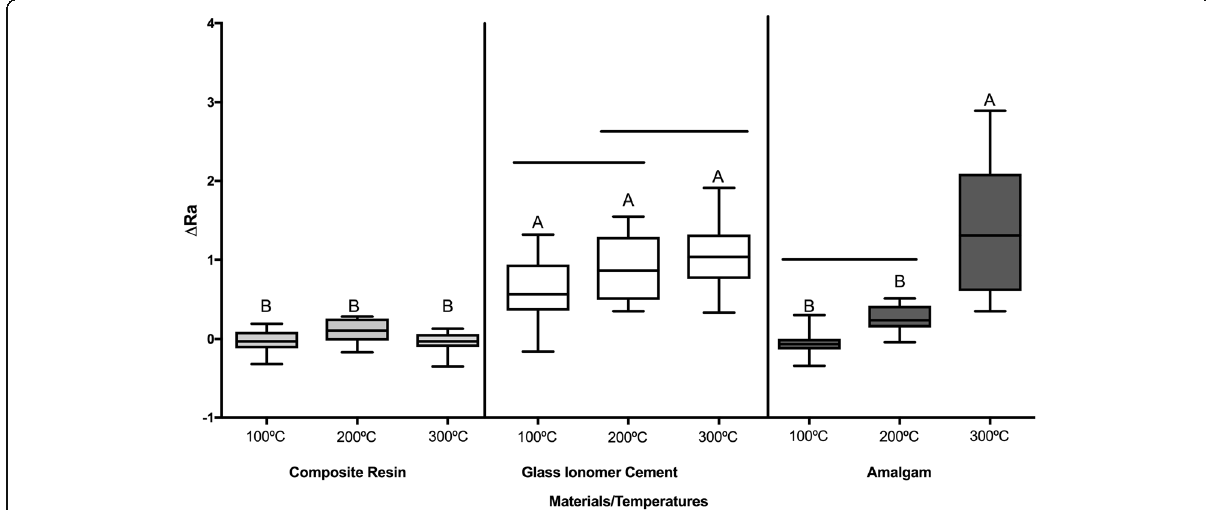
Fig. 2 Graphic representation of the comparison of Δ Ra between the materials when exposed to the heat action (one-way ANOVA, Tukey test, p < .05). For all the comparisons between the sample groups of CR, p > .05. For GIC and amalgam, the horizontal lines over the bars indicate no statistically significant difference ( p > .05). Different letters indicate significant difference ( p < .05) between the materials at the same temperature. CR = composite resin. GIC = glass ionomer cement